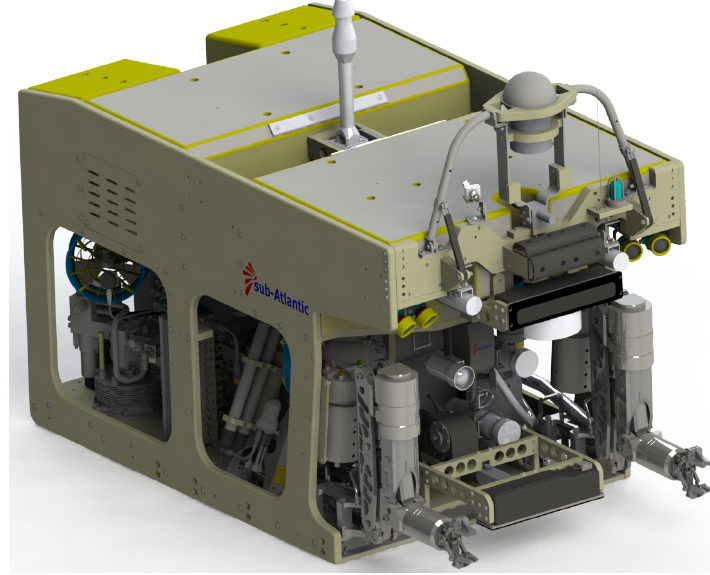
Figure 5. University of Limerick MRE